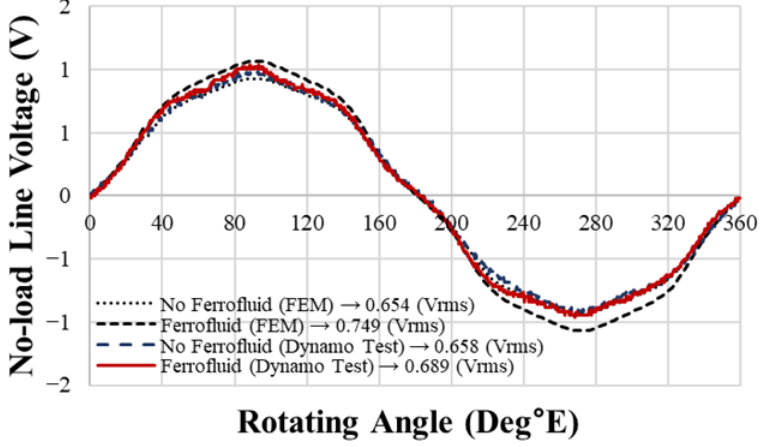
Figure 23. No-load line voltage of the final model through a dynamo experiment and finite element analysis (FEA) simulation (572 rpm).